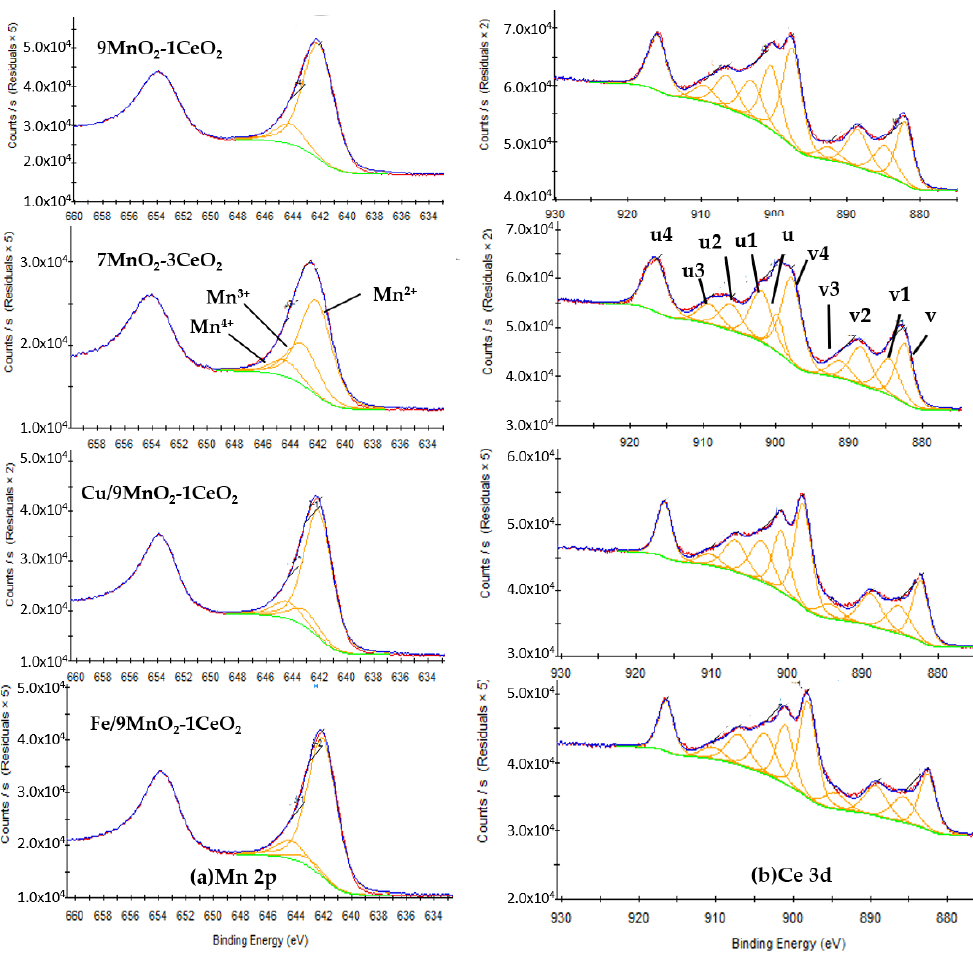
Figure 6. The Mn 2p and Ce 3d XPS spectra of selected catalysts.